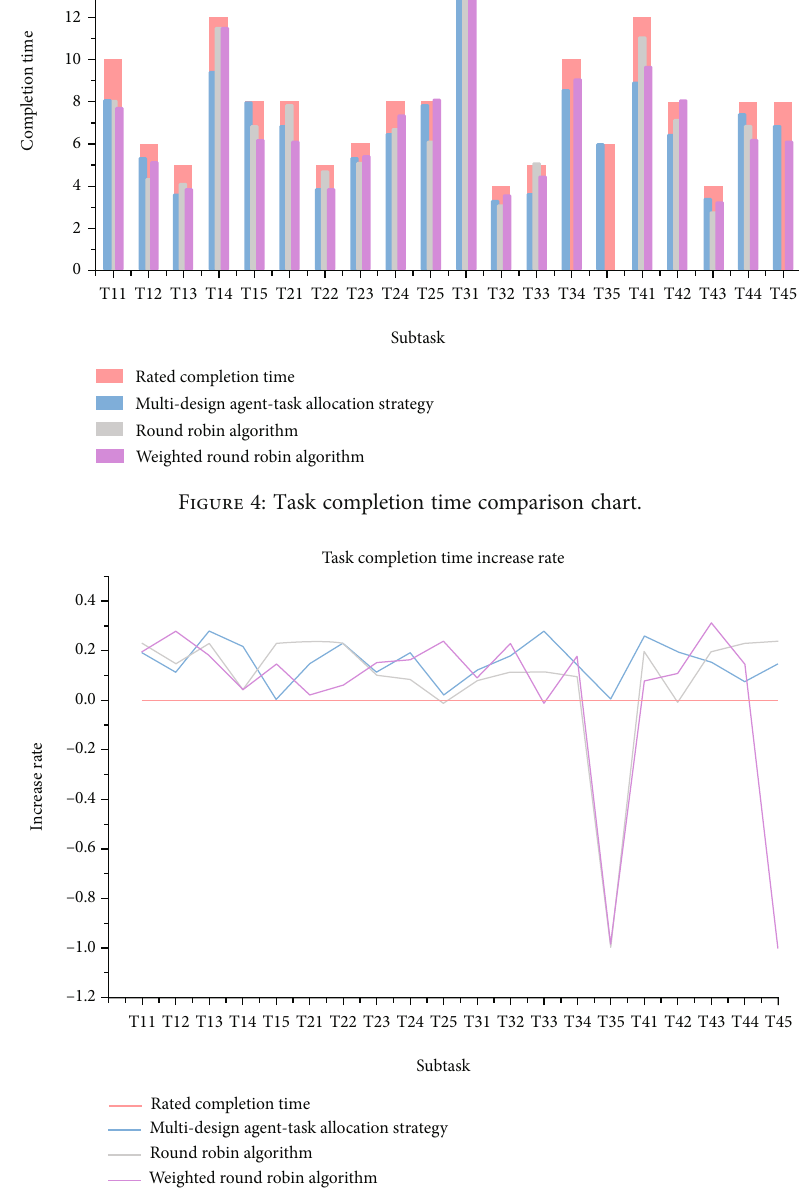
Figure 5: Task completion time increase rate